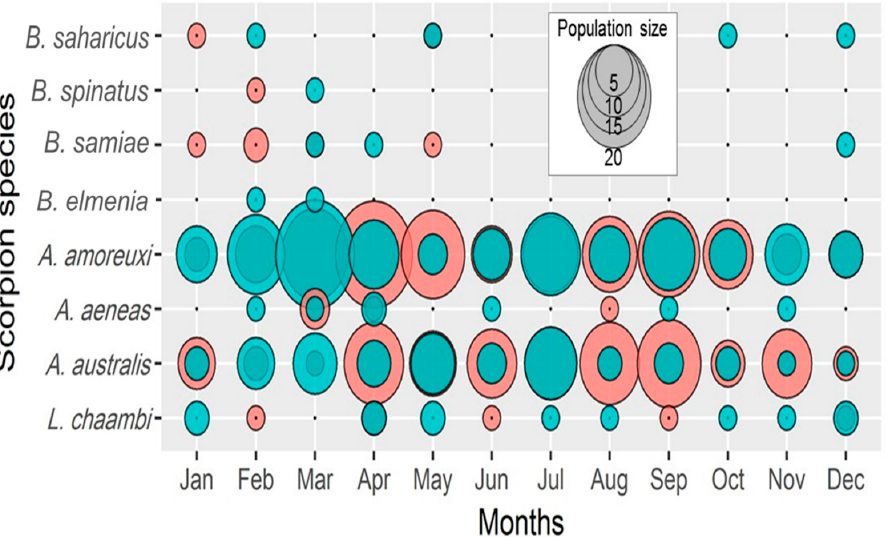
Figure 2. Phenogram representing monthly abundance of scorpions in the Ghardaïa region during the two years of study (red = 2016; green = 2017).